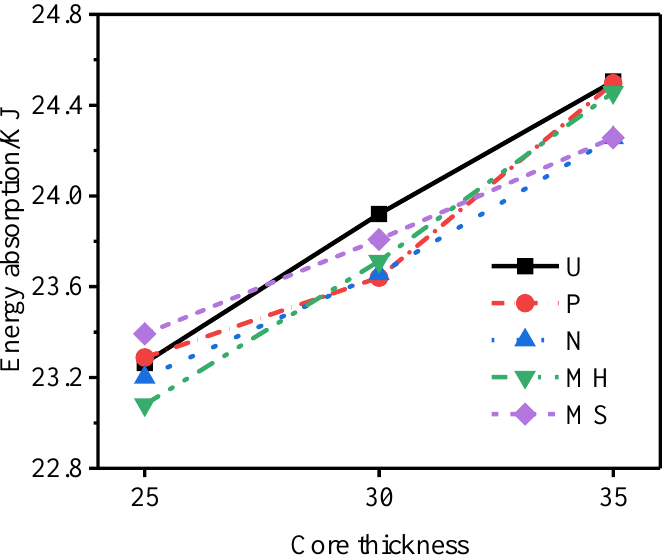
Figure 24. Total energy absorption of sandwich tubes with different core thicknesses.